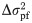
Time-dependent variance of the probability fluxes.The dashed line is the best-fit of the data for Δt < 0.11μs to a linear equation. To have Δσpf2 in the same value scale with the structure functions, the volume V(τ) in Eq (10) was taken as a fraction of the maximum volume (≈ 12.2 × 103 Å3).